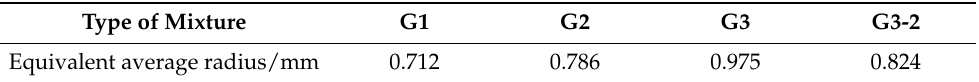
Table 8. Air void equivalent average radius of CRME with different